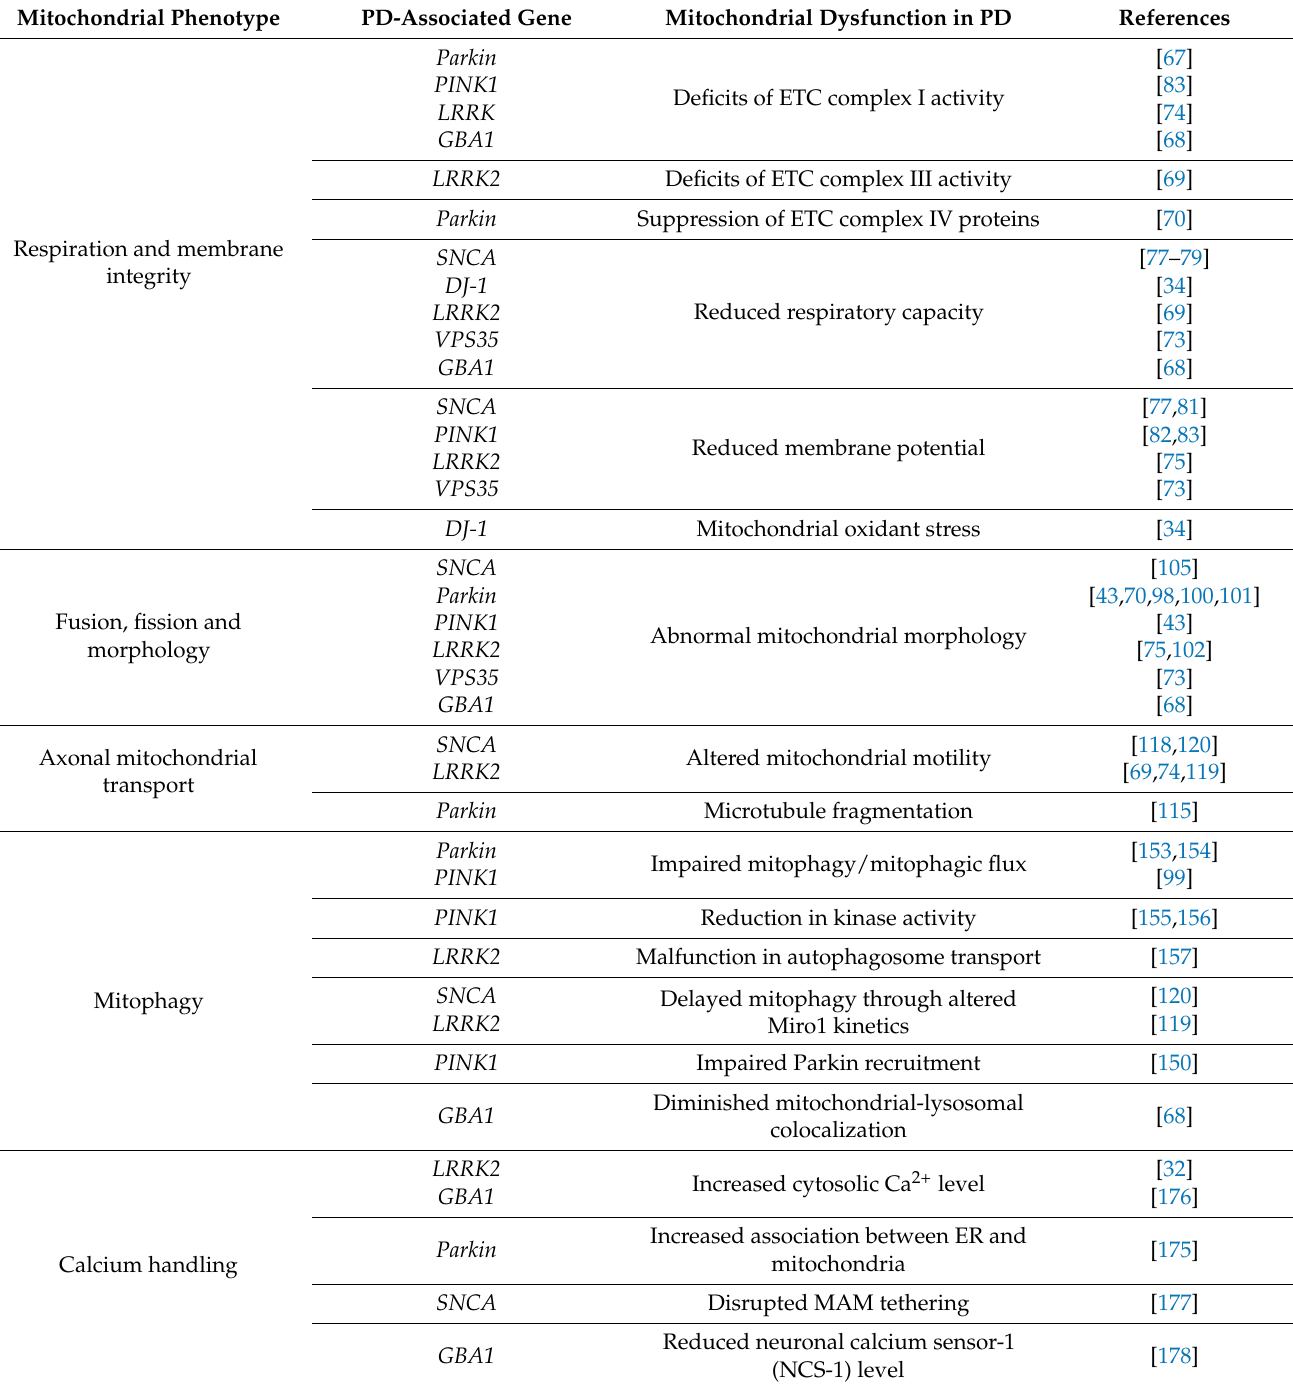
Table 1. Literature on mitochondrial phenotypes described in iPSC-derived neuronal models of Parkinson’s